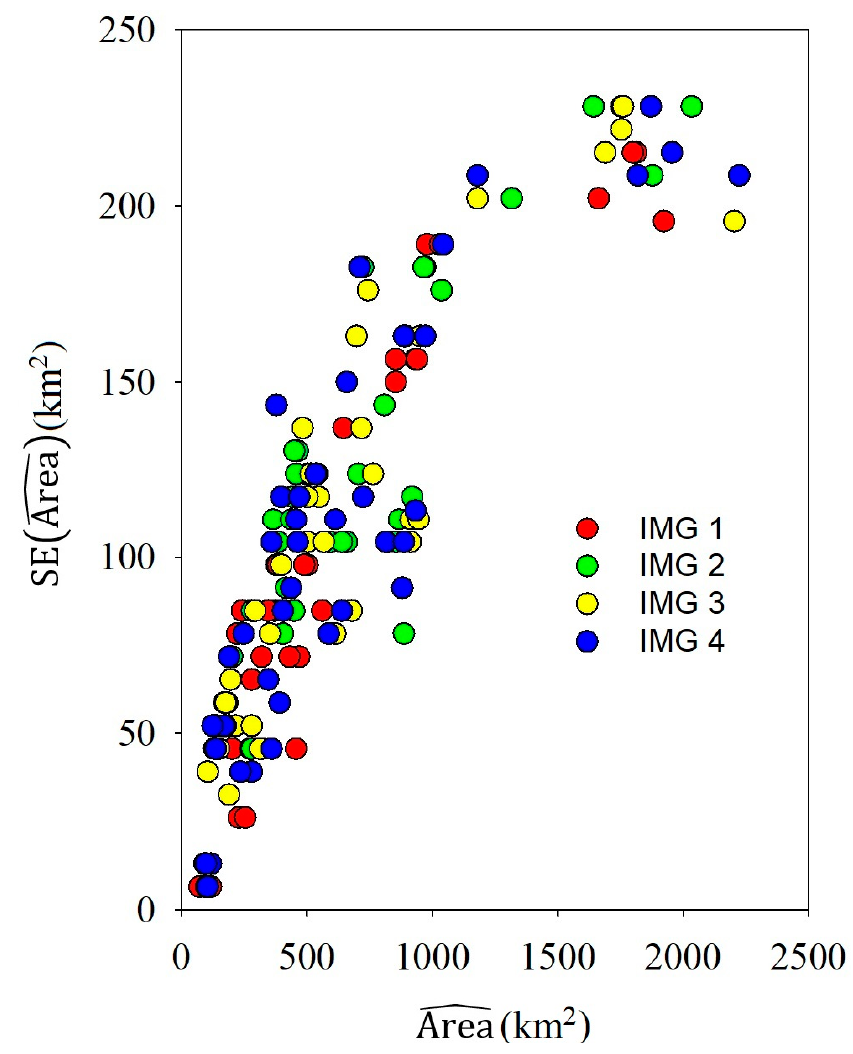
Figure 10. Standard errors (SE) (km 2 ) of class area estimates versus area estimates (km 2 ).